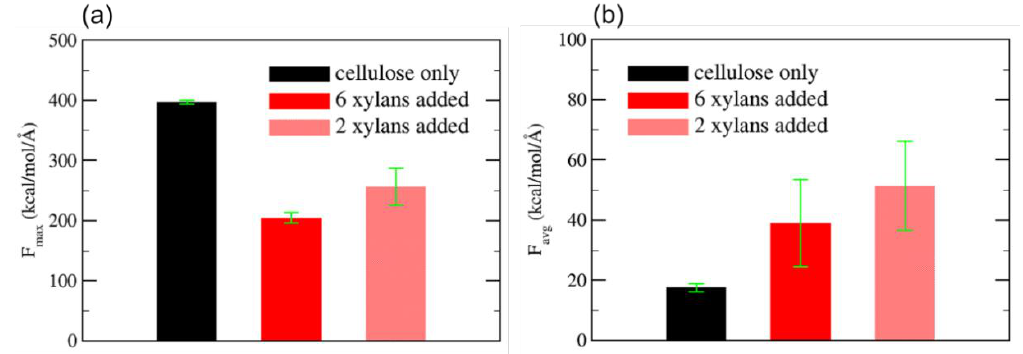
Figure 9. Comparison of adhesion force between cellulose and xylan-cellulose composite cases during ( a ) pulling test and ( b ) sliding test.